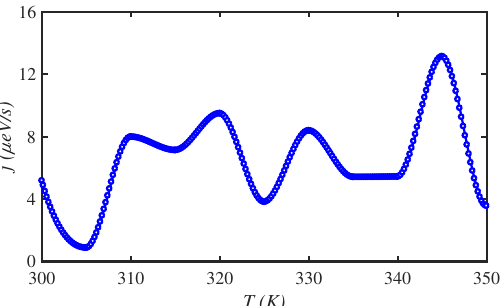
Figure 2. The energy transport rate, j , along a N = 150 site amino acid chain, for different tempera- tures, T